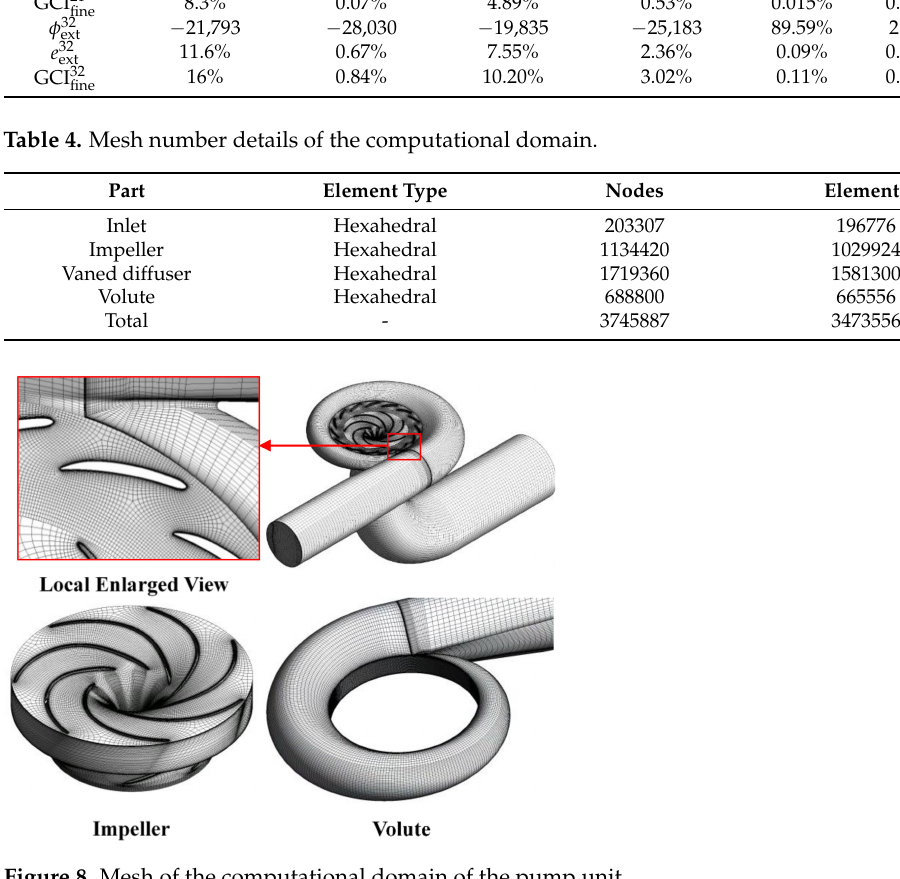
Figure 8. Mesh of the computational domain of the pump